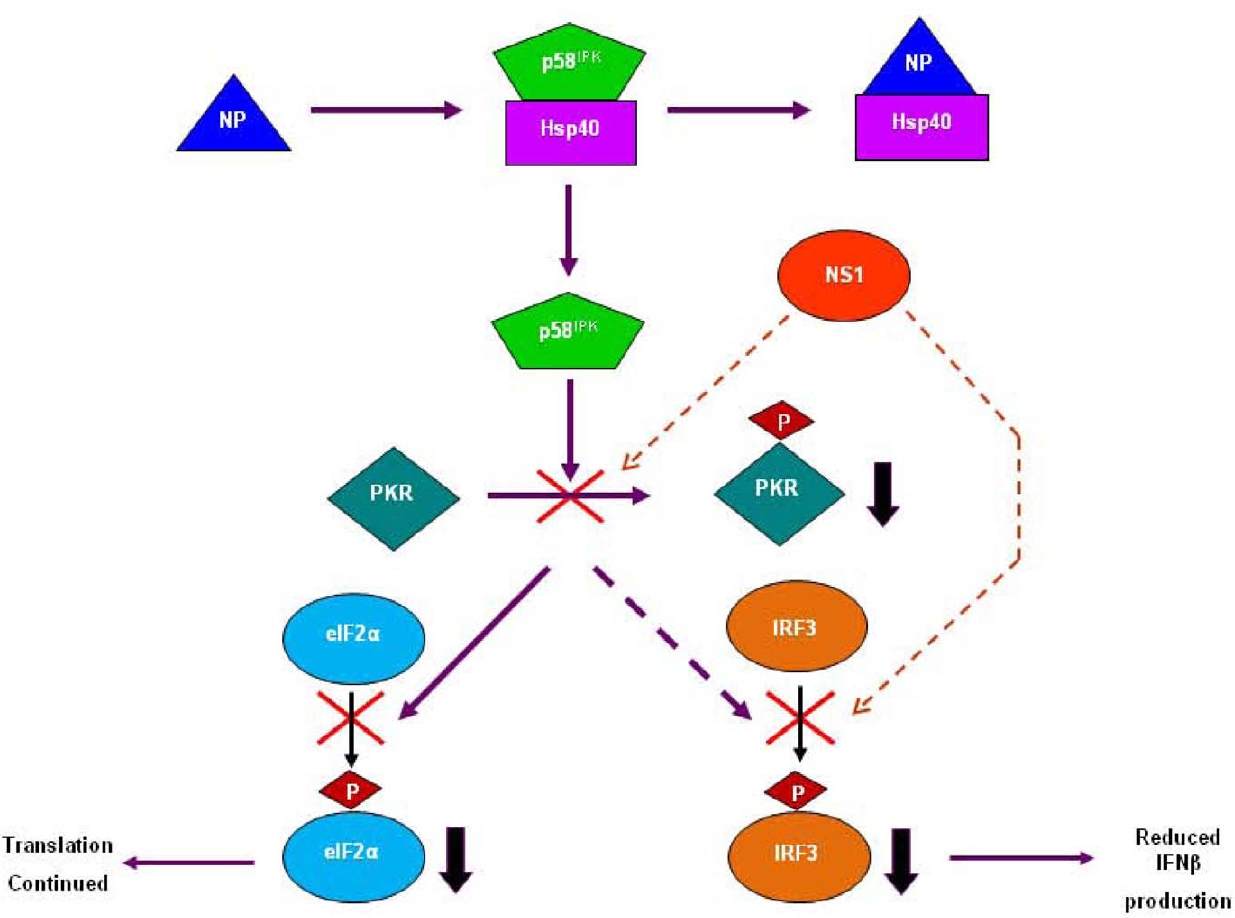
Figure 8. Proposed model for inhibition of PKR mediated host response by influenza nucleoprotein. During influenza virus infection, NP interacts with Hsp40, thereby displacing P58 IPK from the Hsp40-P58 IPK complex. As a result, there is an increased amount of free P58 IPK available in the cell which prevents PKR activation. Downregulation in PKR activity ensures less eIF2 a phosphorylation and continued translation from viral mRNAs. On the other hand reduced PKR activity also leads to reduced IRF3 activation and subsequent IFN b